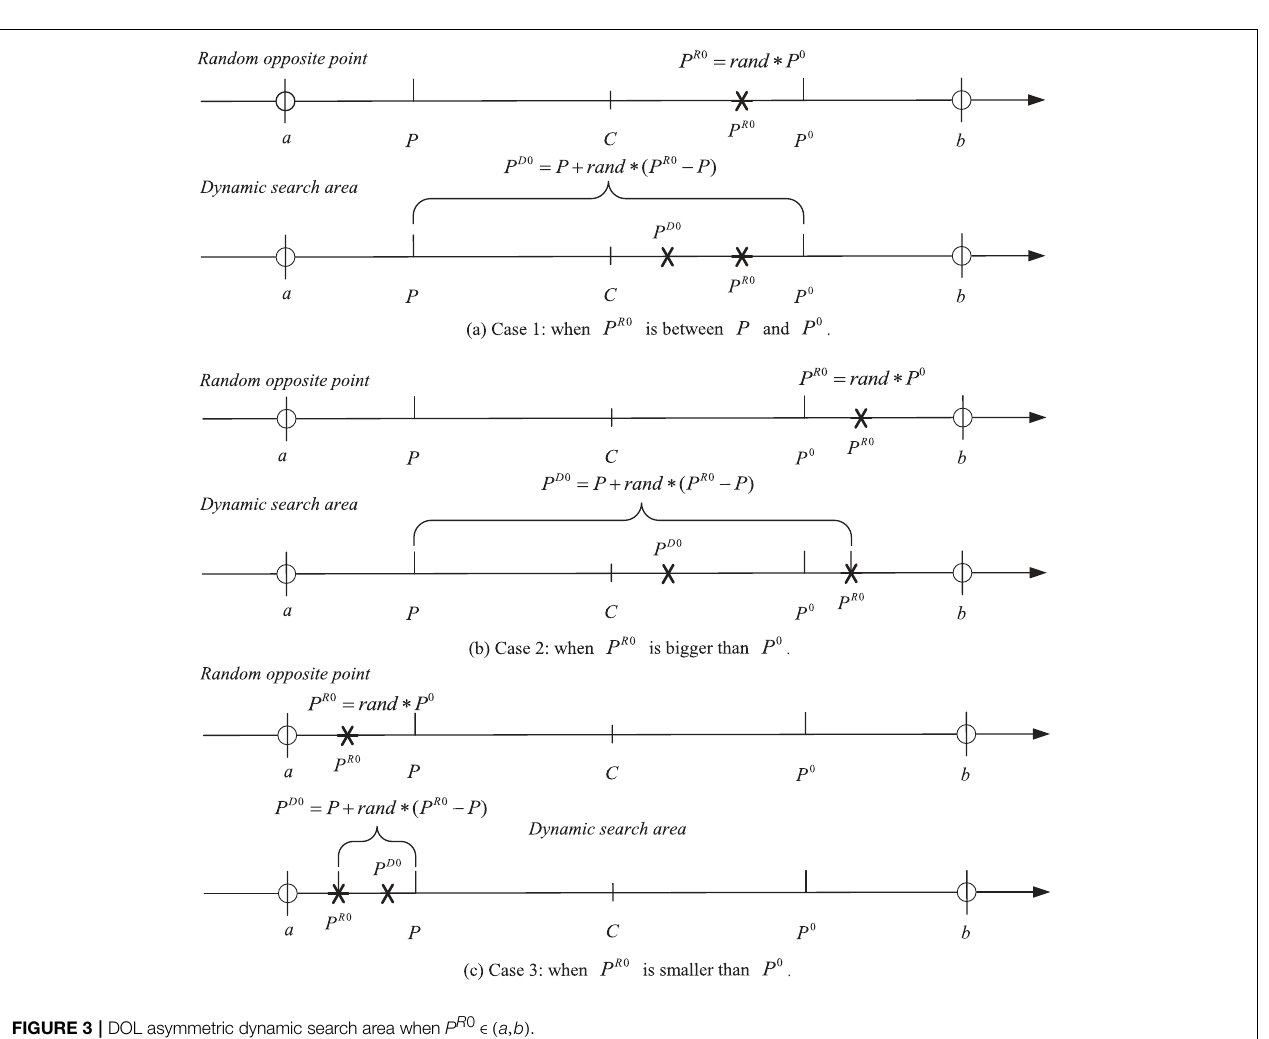
FIGURE 3 | DOL asymmetric dynamic search area when P R 0 ∈ ( a , b )